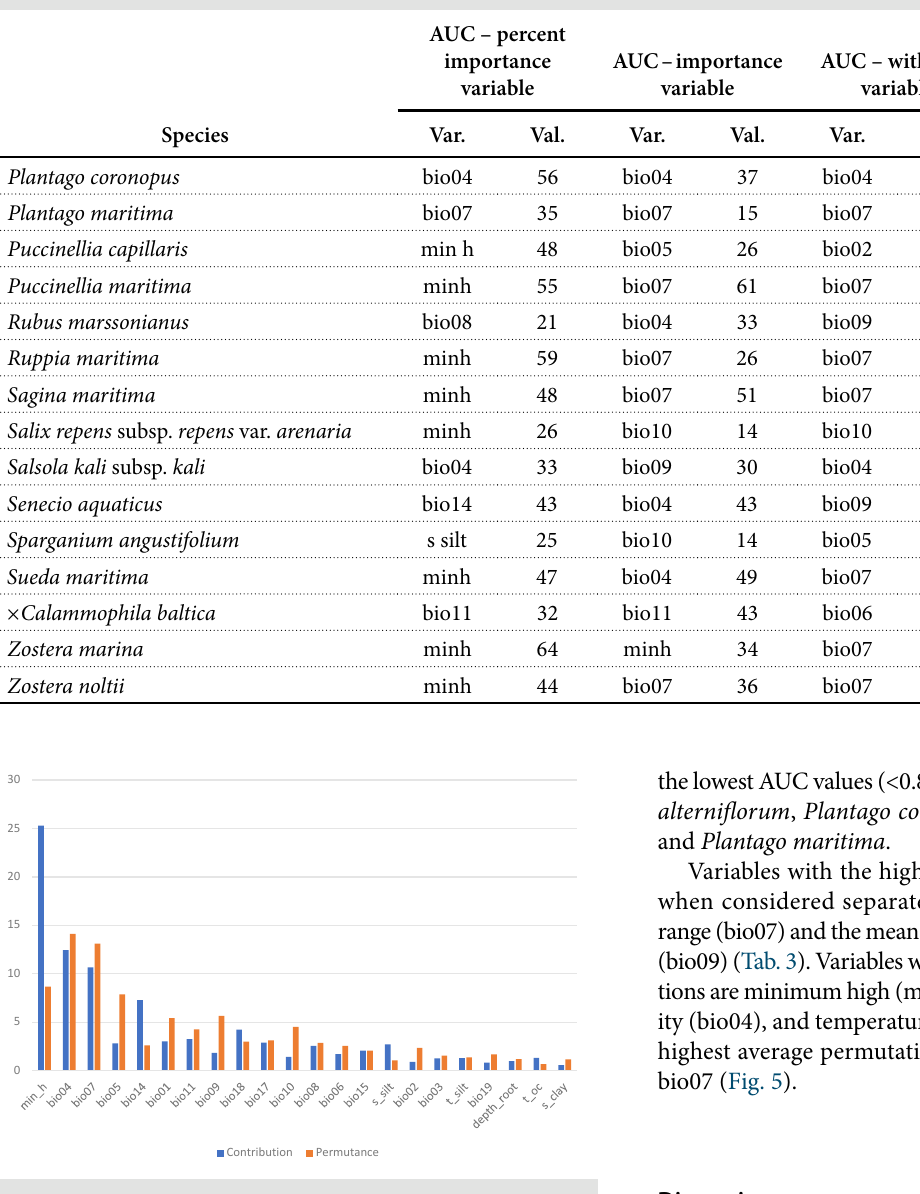
Fig. 5 Average contribution and permutation value of the variable in MaxEnt model (only variable where value